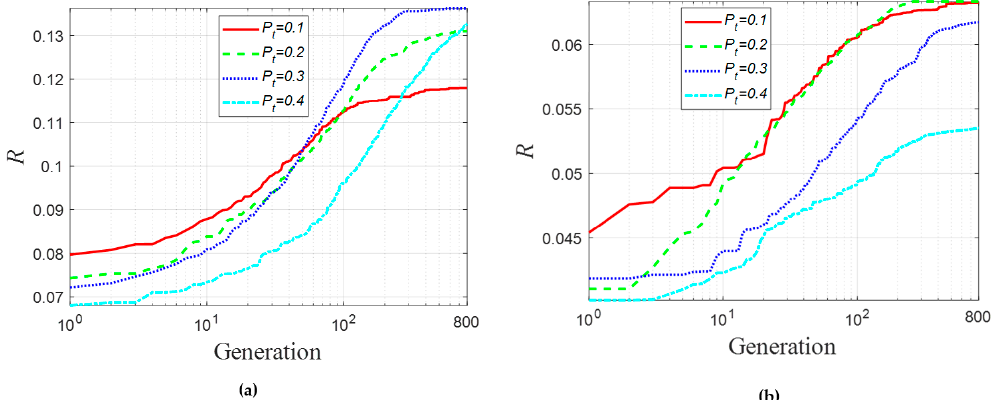
Figure 6. The variation of the index R over all iterations ( a ) based on the generated supply network (SN) and ( b ) based on the realistic SN.